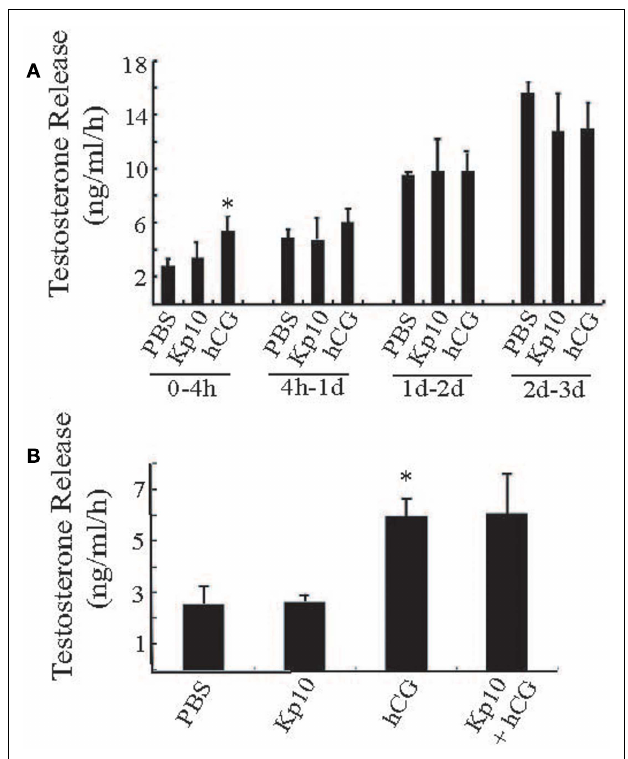
FIGURE 4 |Testing Kp10 stimulation of testosterone release from fresh testes explants . (A) Time course of testosterone release from explanted mouse testes tissue. Pieces of adult mouse testes were cultured in PBS, Kp10 (1 µ M), or hCG (0.6IU/ml), respectively.The media was collected at the time points indicated, and testosterone levels measured by an ELISA. (B) Evaluation of synergistic action of Kp10 on hCG-mediated